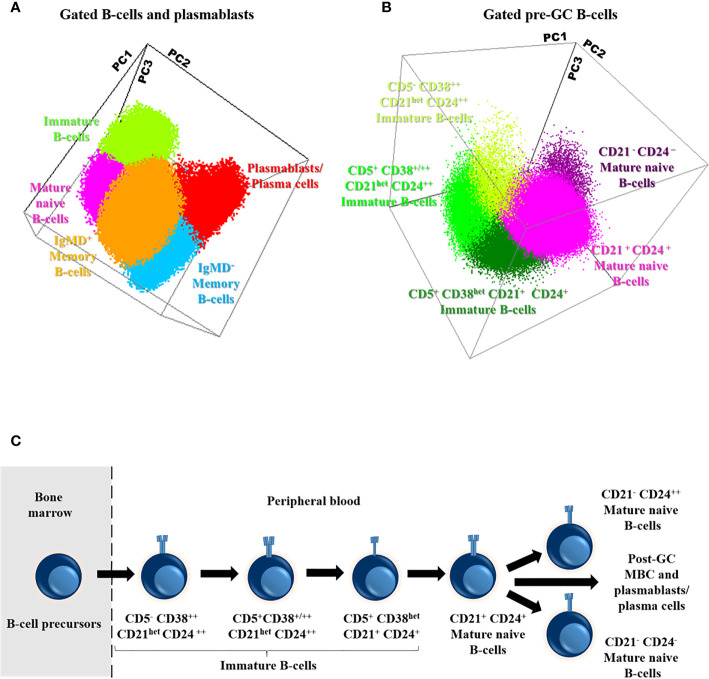
Distribution of the major subsets of immature, naive and memory B cells (MBC) and plasmablasts/plasma cells (A), including the different subsets of pre-germinal-center (GC) B-cells (B), in blood of a representative adult healthy donor (HD) and their maturation-associated relationship (C). Three-dimensional principal component (PC) analysis (PCA) plots in (A, B) were built based on PC1 (A: mean fluorescence intensity of CD27, 29.25%; IgD, 22.56%; IgM, 20.45%; CD21, 11.16%; CD38, 9.63% and CD5, 6.95%; B: mean fluorescence intensity of CD21, 30.15%; CD24, 27.64%; CD38, 23.07% and CD5, 19.14%), PC2 (A: mean fluorescence intensity of IgM, 43.89%, CD27, 34.62%, CD38, 10.18%, IgD, 9.96%; CD21, 1.16% and CD5, 0.18%; B: mean fluorescence intensity of CD21, 43.66%, CD38, 23.62%, CD24, 17.09% and CD5, 15.63%) and PC3 (A: mean fluorescence intensity of CD38, 42.02%, CD21, 19.56% CD27, 12.19%, CD5, 12.03%, IgD, 11% and IgM, 3.20%; B: mean fluorescence intensity of CD5, 56.16%, CD24, 27.80%, CD38, 14.85% and CD21, 1.19%) vectors using the (balanced) automated population separator (APS1-2) 3-D view of Infinicyt. In both (A, B), the distinct color-coded cell populations displayed were gated as described in
Supplementary Figure 1
.